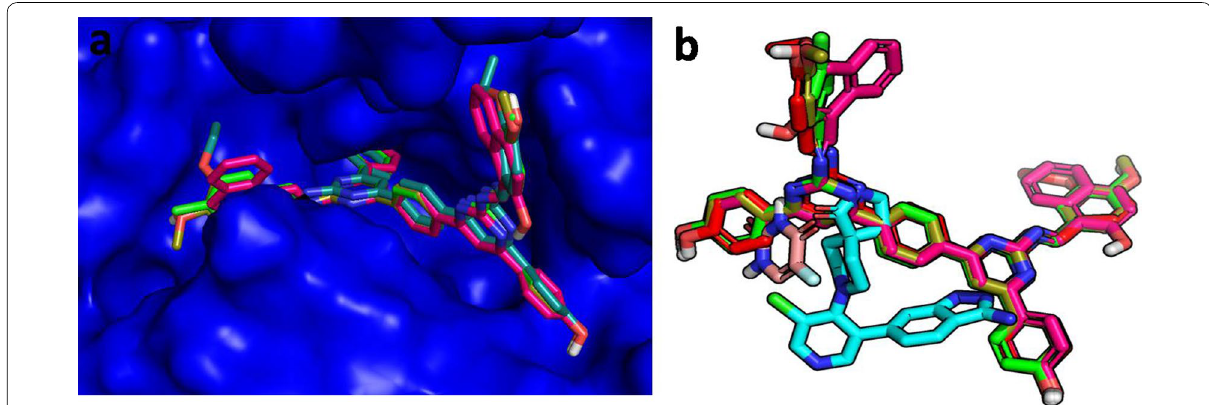
Fig. 4 a Binding mode of four most active compounds into the CDK8 active site. b Overlay of Compound q1 (magenta color), Compound q5 (green color), Compound q8 (red color) and Compound q13 (split pea color) and PDB Complexed ligand 5XG (color cyan) and 5-Fluorouracil (salmon color) as the